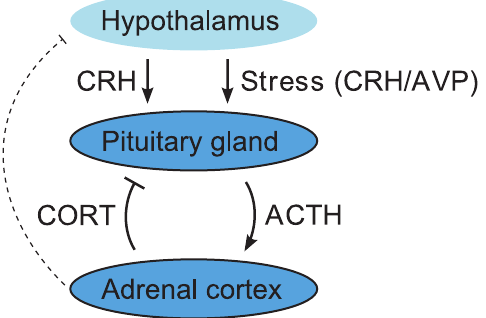
Figure 2. Schematic of the HPA axis. Under basal conditions, the pituitary gland releases readily-available ACTH in response to CRH secreted from the hypothalamus. In response to ACTH, theadrenal cortex synthesizes and secretes CORT, which feeds back primarily at the pituitary gland, but also at higher centres in the brain (depicted by the dashed line), to inhibit ACTH secretion. This dynamic balance between thepositivefeed-forward actionof CRH andthe negative feedback action of CORT at the level of the pituitary gland has been suggested theoretically to regulate the oscillatory activity of the pituitary-adrenal system. In addition to basal regulation, acute stressors result in additional hypothalamic secretion (CRH and AVP) which act to further stimulate the pituitary-adrenal network. Theinterplay between basal oscillatory activity and acute stress perturbations is the focus of this study.